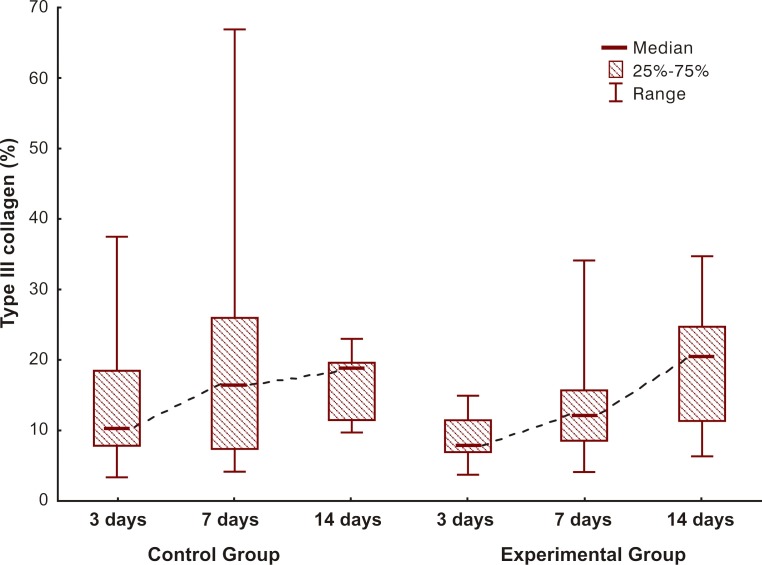
Comparison of groups for immature collagen.